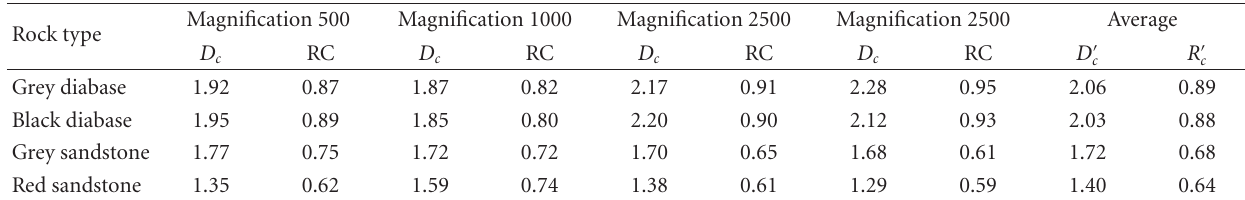
Figure 9: Rock failure patterns under uniaxial compression. Table 1: Fitting results of fractal dimension for di ff erent